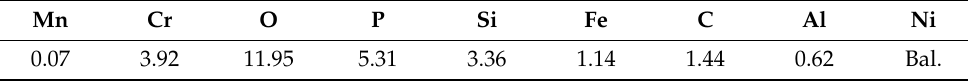
Table 2. Chemical composition of the Ni25 powder (mass fraction, %).